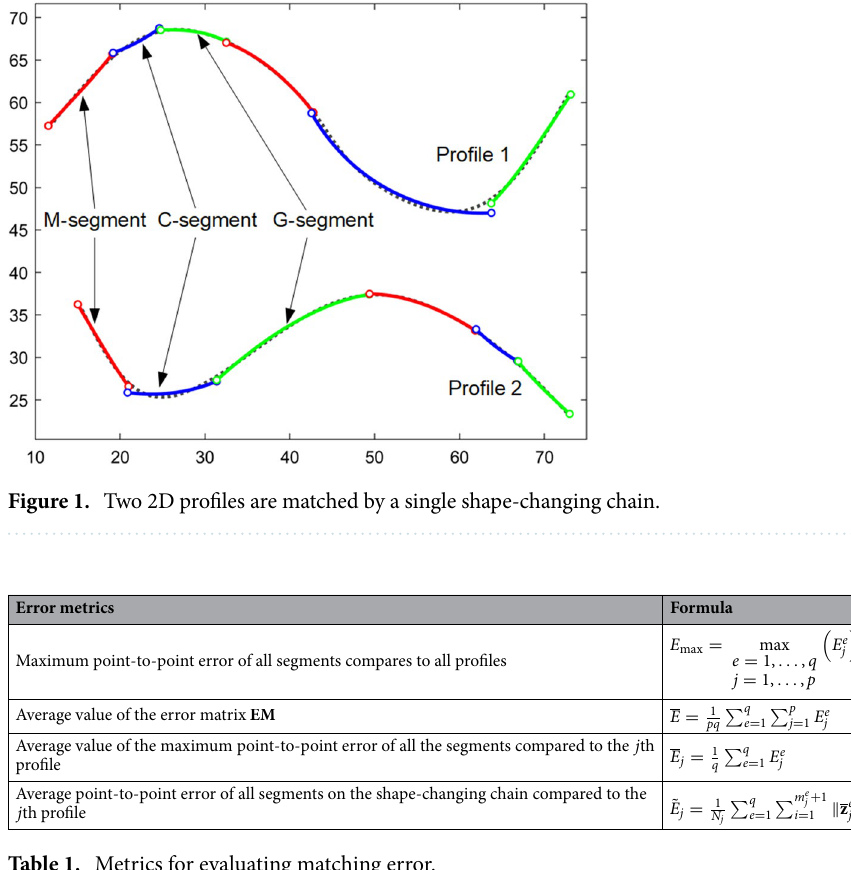
Table 1. Metrics for evaluating matching error.